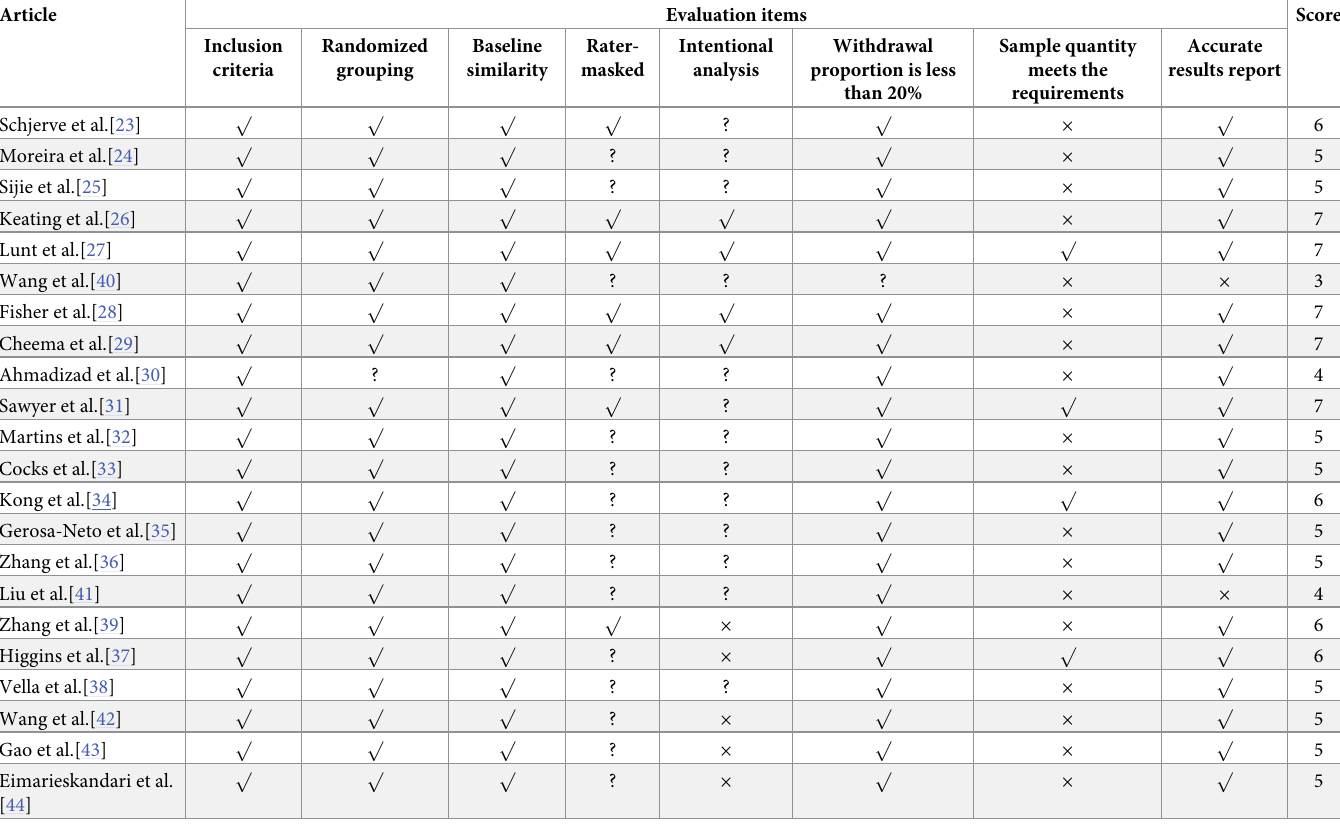
Table 2. Risk of bias assessment of included